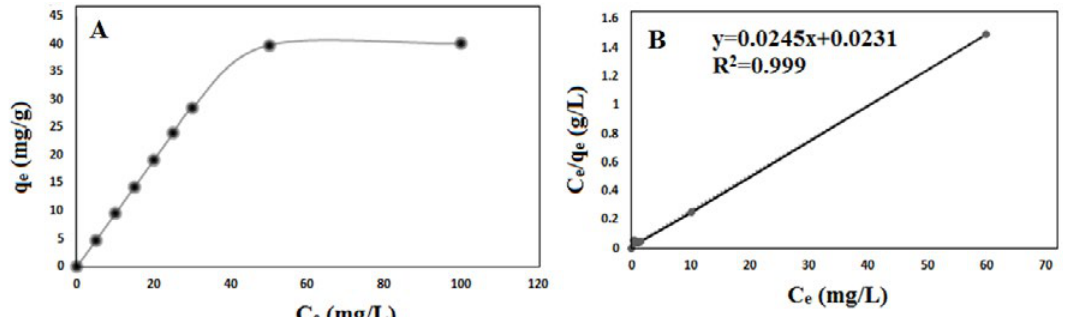
Fig. 9. (A) Adsorption isotherm of MB on Fe